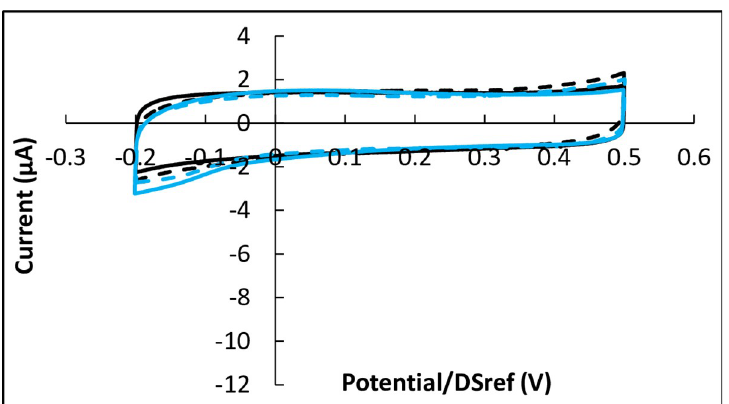
cells; in each case dotted lines are duplicates. Potentials are expressed vs. the DropSens pseudo-reference (DSref), values vs. SHE can be obtained by adding 0.290 V.